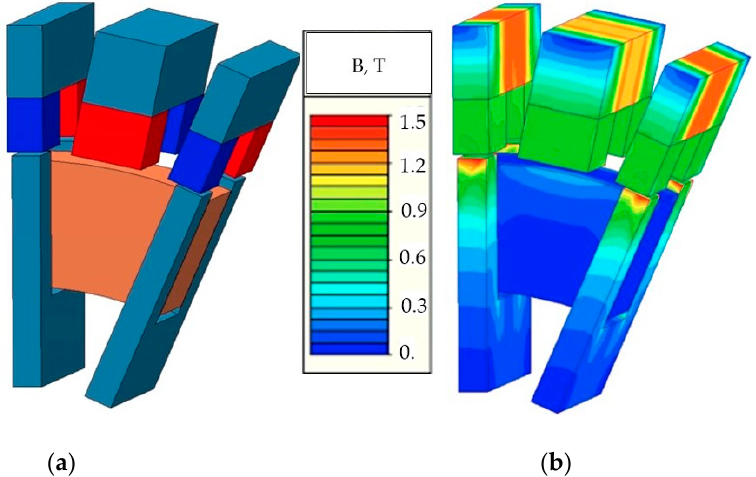
Figure 7. Computer model of the TFM segment under no current: ( a ) 3D FEM model of the segment and ( b ) magnetic flux density distribution in the